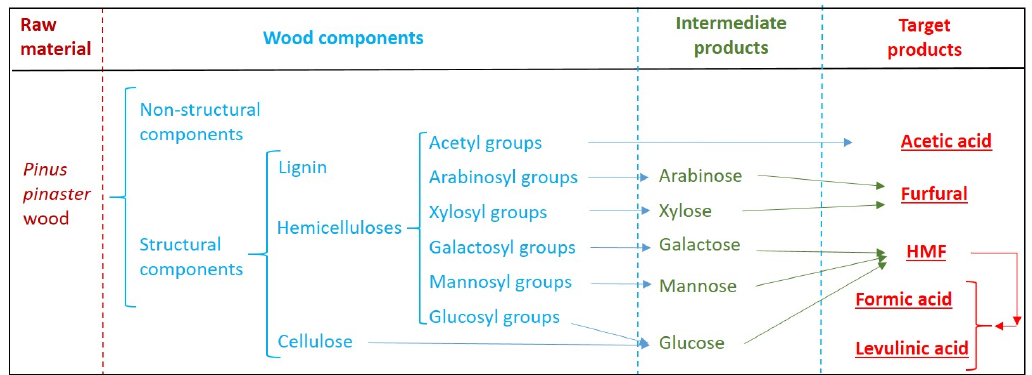
Figure 1. Scheme followed in this work for producing platform chemicals from Pinus pinaster wood polysaccharides.